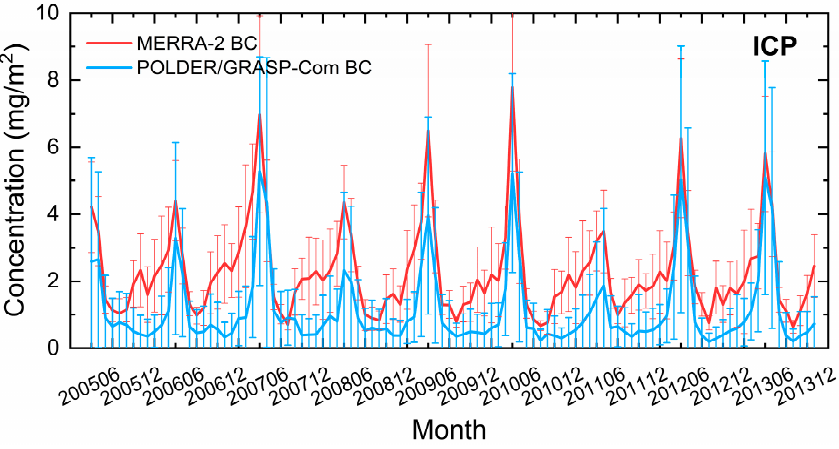
Figure 16. Same as Figure 13, but for Indo–China Peninsula (ICP)